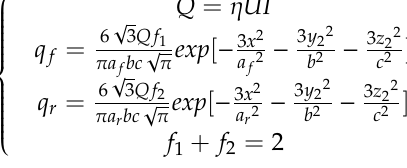
Figure 3. Conversion of coordinates.